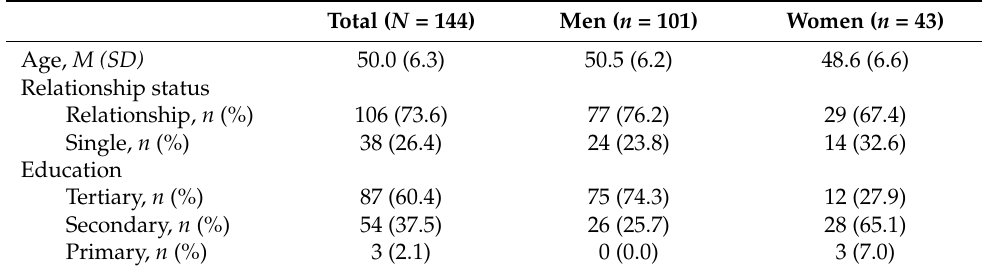
Table 1. Participants’ sociodemographic